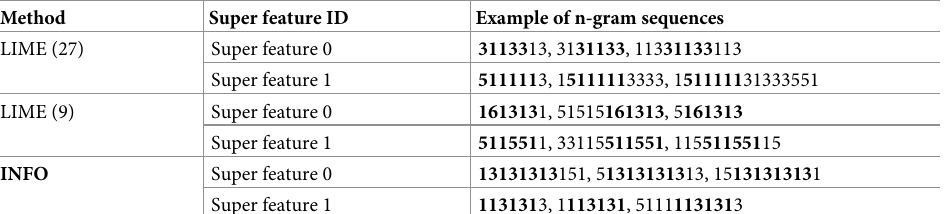
Table 3. Example of CMD super features generated by LIME and INFO. LIME (27) and LIME (9) show the cluster- ing results of two instances from class 27 and class 9 in the SEC-seq dataset, respectively. INFO makes the same super features over all instances while LIME gives inconsistent super